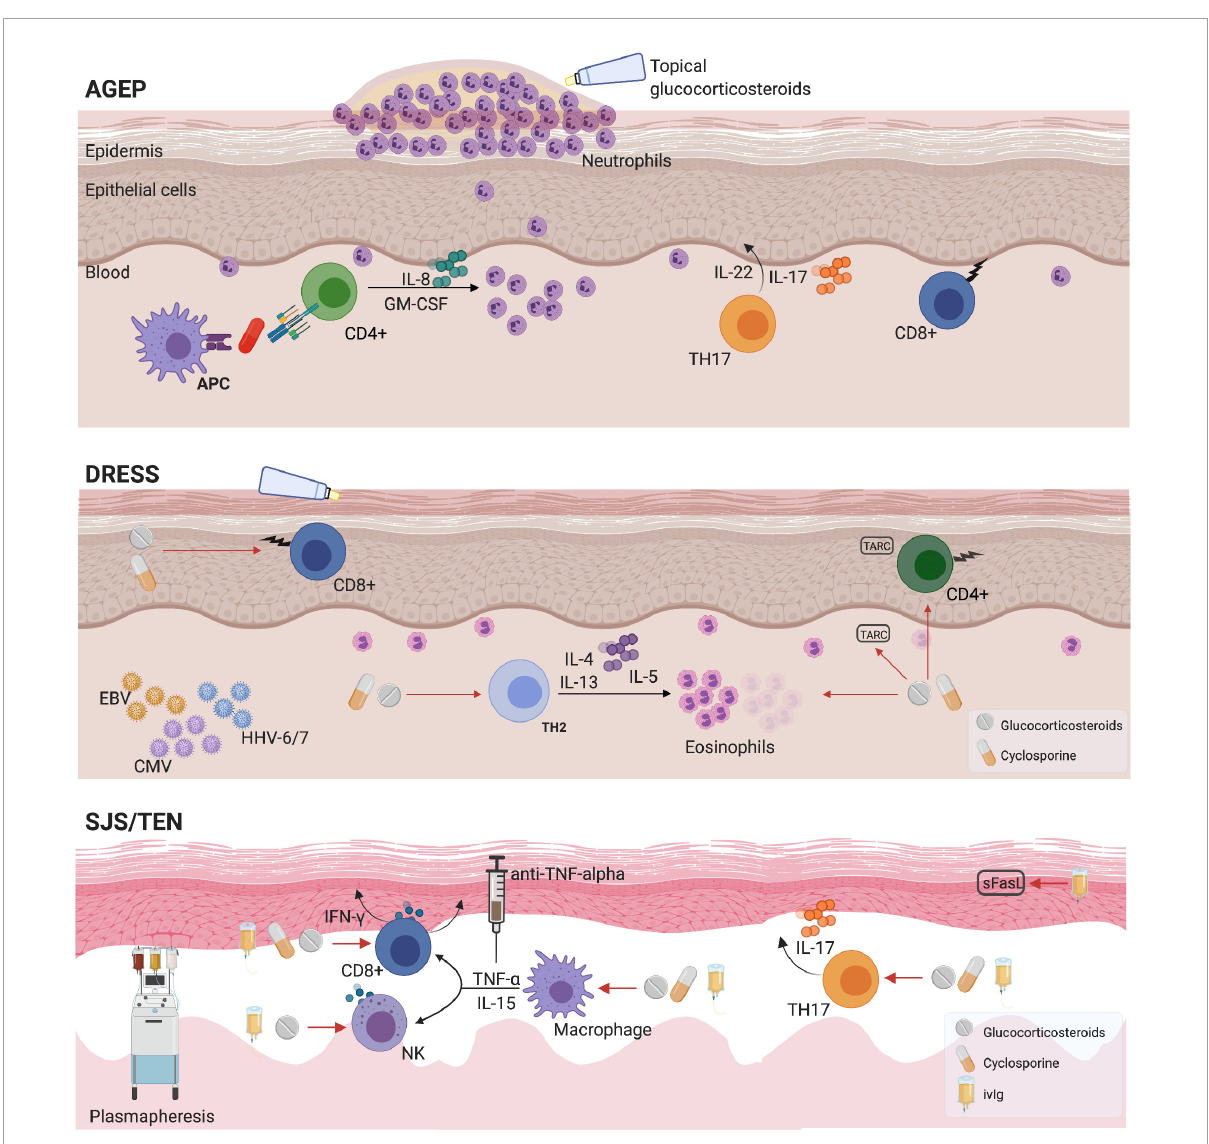
FIGURE2 Mechanisms and pharmacological management for T-cell mediated reactions. AGEP, acute generalized exanthematous pustulosis; APC, antigen presenting cell; CMV, cytomegalovirus; DRESS, drug reaction with eosinophilia and systemic symptoms; EBV, Epstein-Barr virus; HHV, Human Herpesvirus; GM-CSF, granulocyte macrophage-colony stimulating factor; IFN- γ , Interferon gamma; IL, interleukin; sFasL, soluble Fas ligand; SJS, Stevens-Johnson syndrome; TARC, thymus and activation-regulated chemokine; TEN, toxic epidermal necrolysis; TNF, tumor necrosis